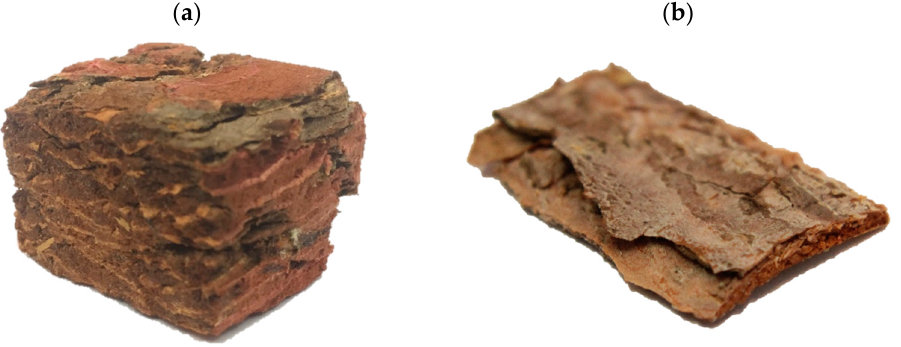
Figure 1. The samples of the Pinus sylvestris L. bark. ( a ) mature and ( b ) juvenile were taken for investigation.